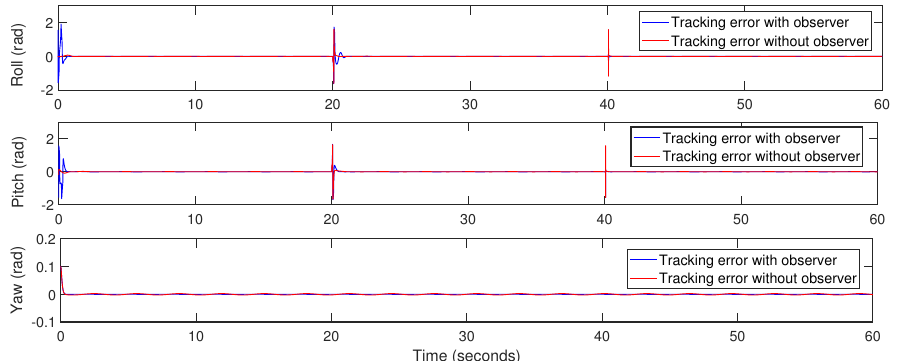
Figure 18. Attitude tracking error when [sin ( 2 t ) sin ( 2 t ) sin ( 2 t ) ] is applied to the attitude subsystem. Next, we apply the Von Karman wind gust model (turbulence model) as an external disturbance. External disturbances such as wind gusts have more impact in the takeoff, landing hovering mode in actual scenarios. We present simulation work for the takeoff, landing and hovering phase with a Von Karman turbulence model that evaluates the proposed nonlinear controller’s performance. Figure 19 shows the position tracking with wind gust, providing small changes in the positioning subsystem during takeoff, landing and hovering.